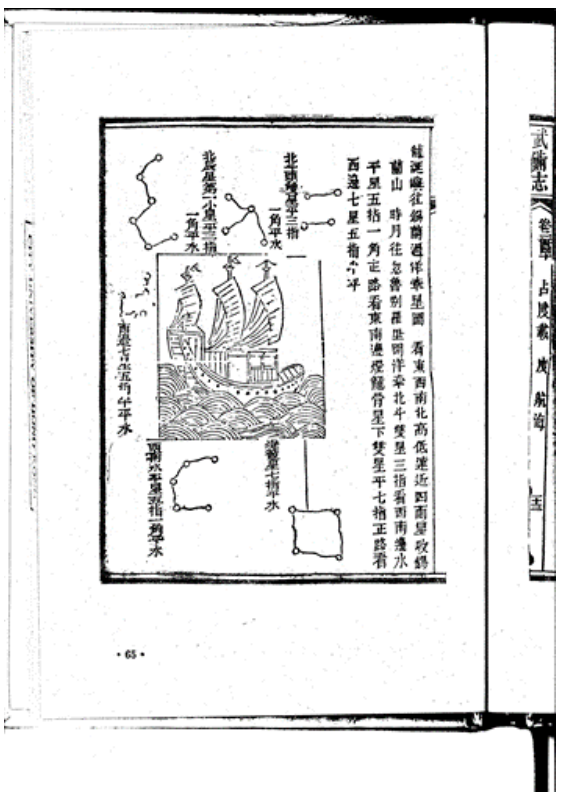
Figure 6. Big Dipper in the navigation maps. The Big Dipper is on the left of the upper section. Zhenghe Figure 6. Bigger Dipper in the navigation maps. Zhenghe hanghai tu (The Navigation Maps of Zheng He ’s hanghai tu (The Navigation Maps of Zheng He’s Expedition) , p. Expedition) , p. 65.